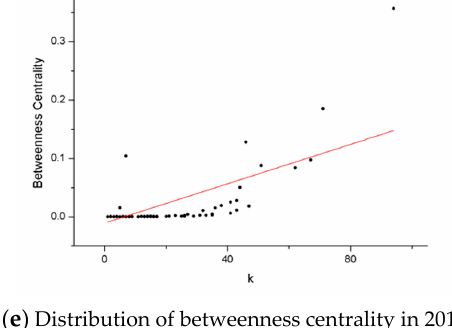
Figure 8. Distribution of betweenness centrality during 2014–2018. Figure 8 contains five graphs, which are arranged by year as: ( a ) 2014, ( b ) 2015, ( c ) 2016, ( d ) 2017, ( e ) 2018.